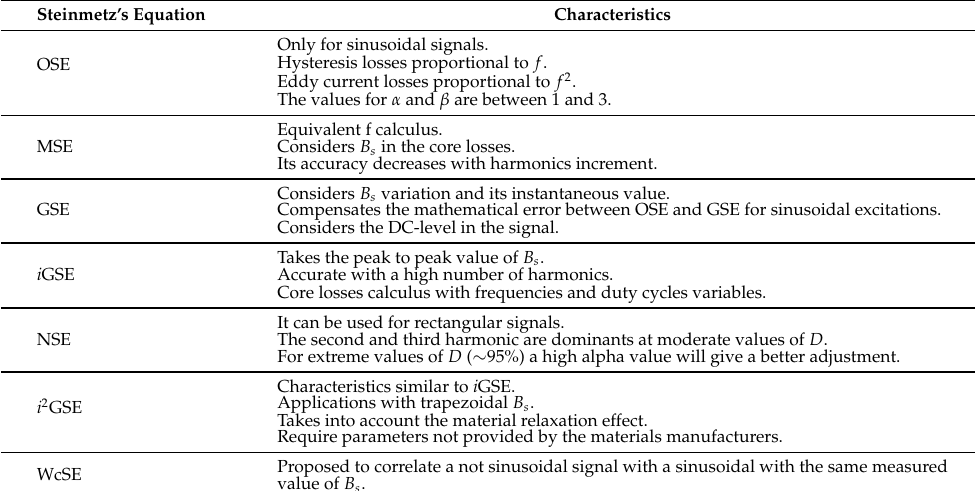
Table 1. Details of Steinmetz’s